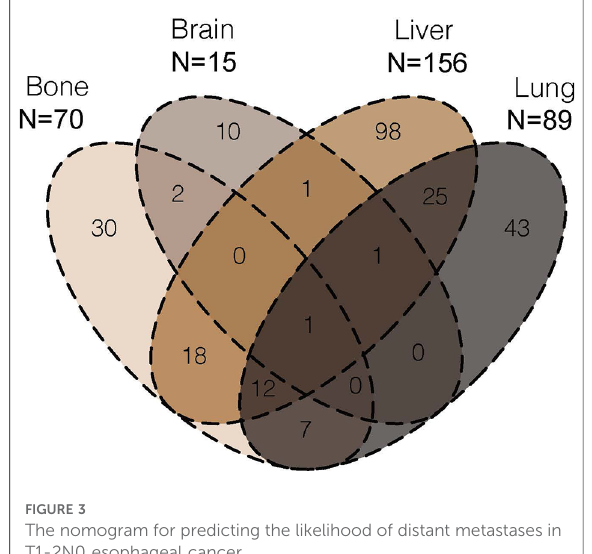
FIGURE 3 The nomogram for predicting the likelihood of distant metastases in T1-2N0 esophageal cancer.